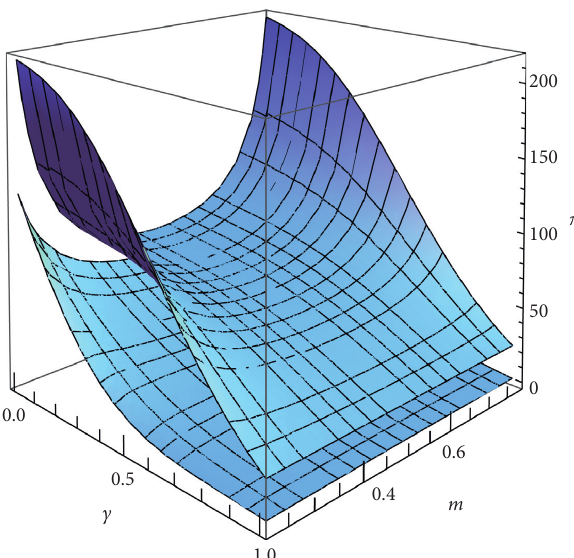
Figure 5: Changes in the overall supply chain profit under the centralized rebate with manufacturers’ offering r dTSC ∗